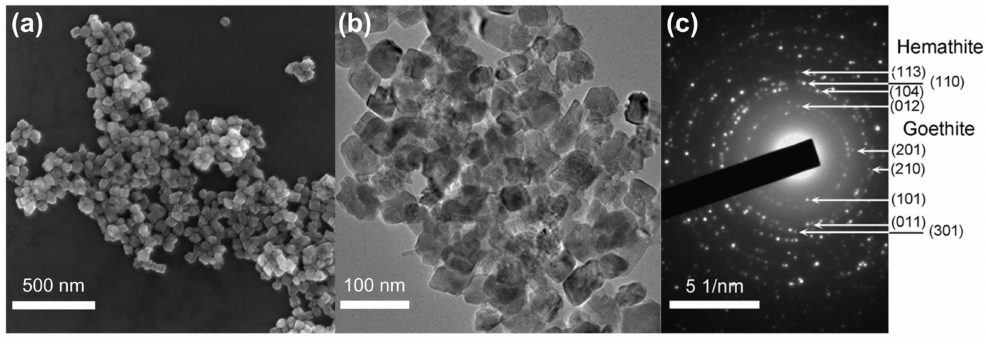
Figure 2. ( a ) Scanning electron microscopy; ( b ) Transmission electron microscopy images of the nanoparticles (NPs); ( c ) Selected area electron di ff raction pattern of the